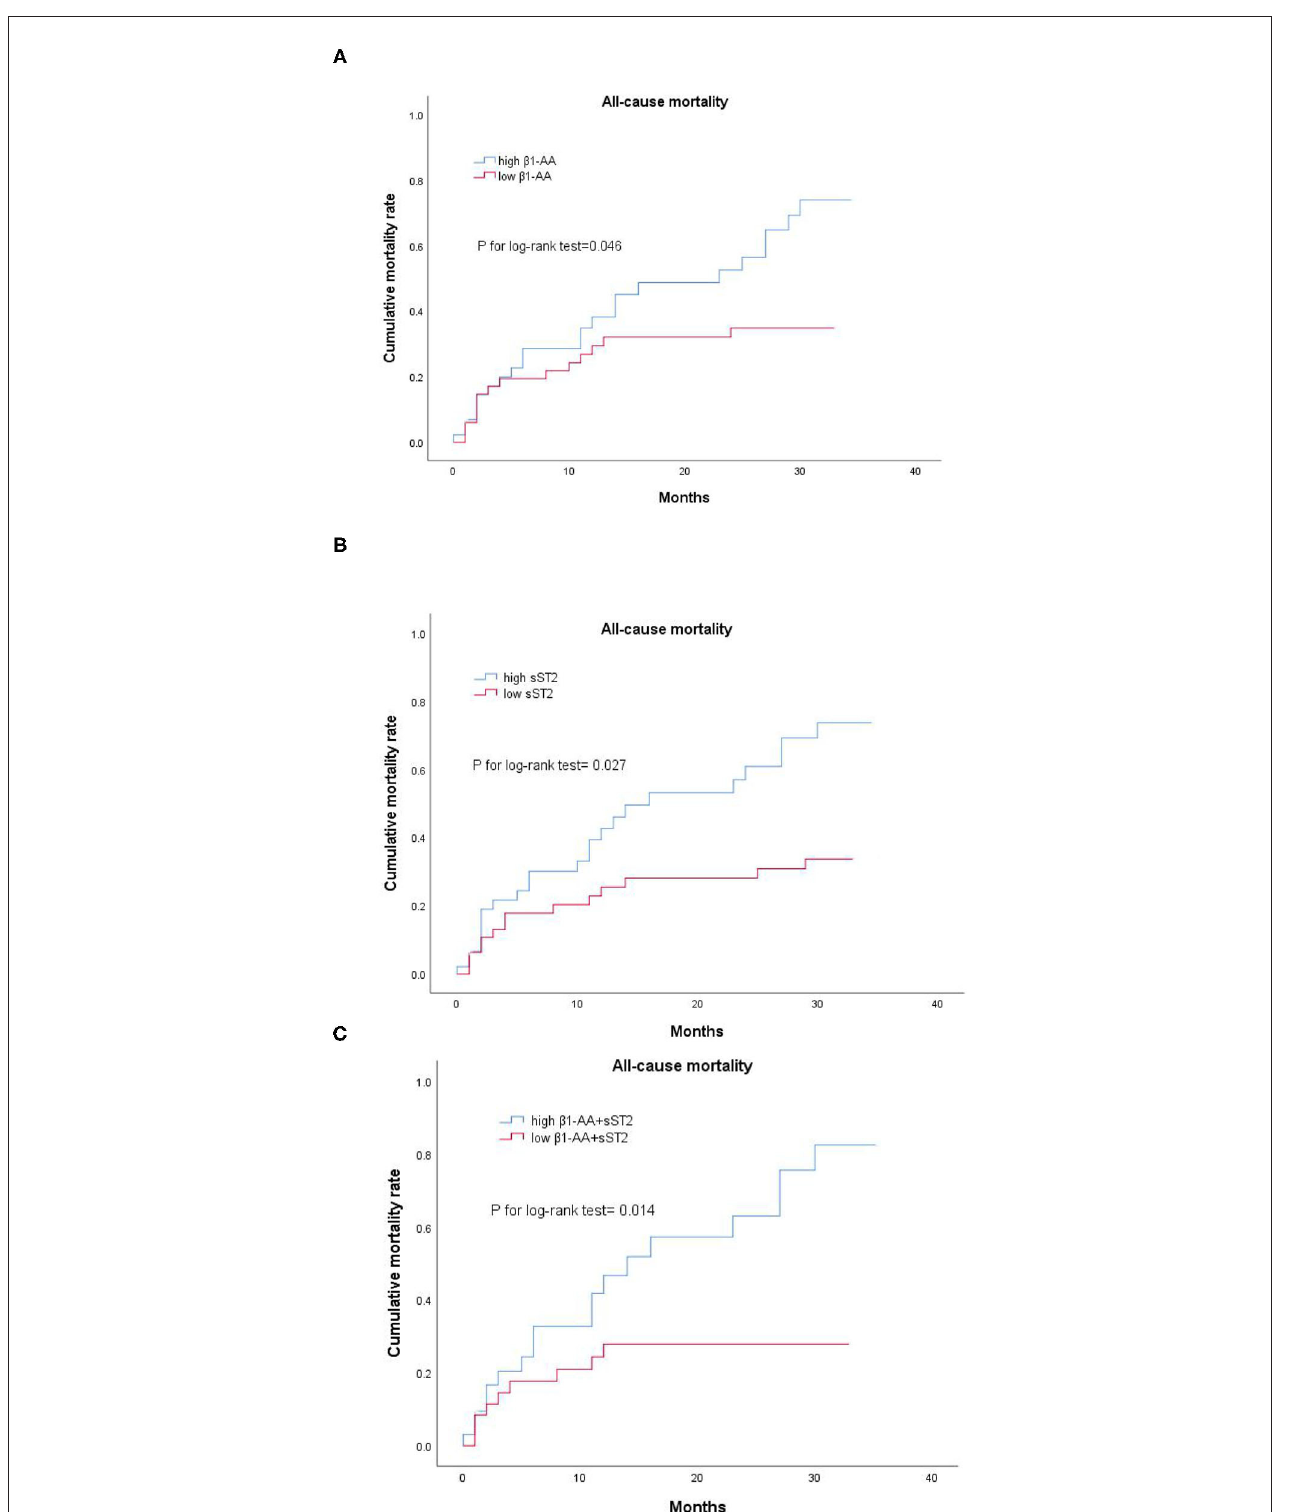
FIGURE 1 | (A–C) Survival analysis of β 1-AA and sST2 baseline levels in patients with ADHF. Kaplan-Meier analysis showed that patients with high β 1-AA and sST2 had obviously higher cumulative rates of the all-cause mortality than those with low β 1-AA and sST2. High β 1-AA and high sST2, the level of β 1-AA and sST2 was above their mean or median; low β 1-AA and low sST2, the level of β 1-AA and sST2 was below their mean or median. High β 1-AA + sST2, the level of β 1-AA and sST2 was both above their mean or median; low β 1-AA + sST2, the level of β 1-AA and sST2 was both below their mean or median.